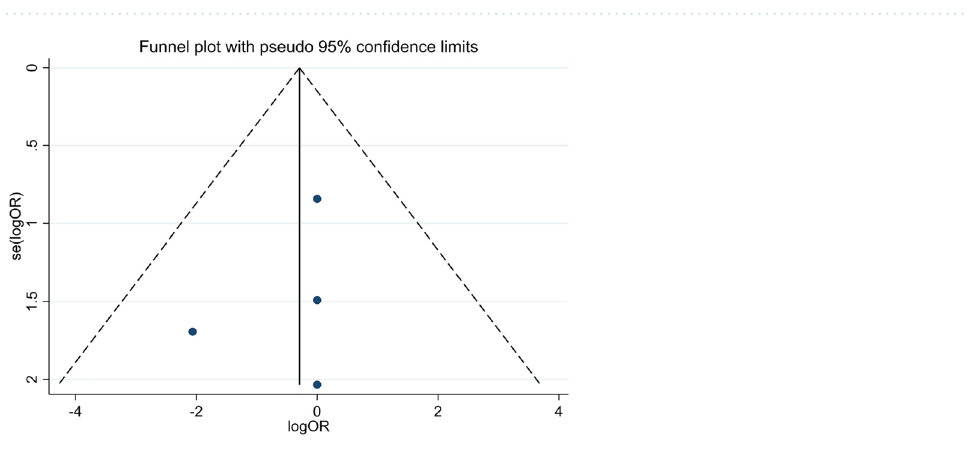
Figure 4. Forest plot of studies measuring tumor recurrence of different treatment modalities in OSSN. The recurrence rate of each study and the 95% confidence intervals (CIs) are presented. The diamond at the bottom represents the overall recurrence rate for all studies.